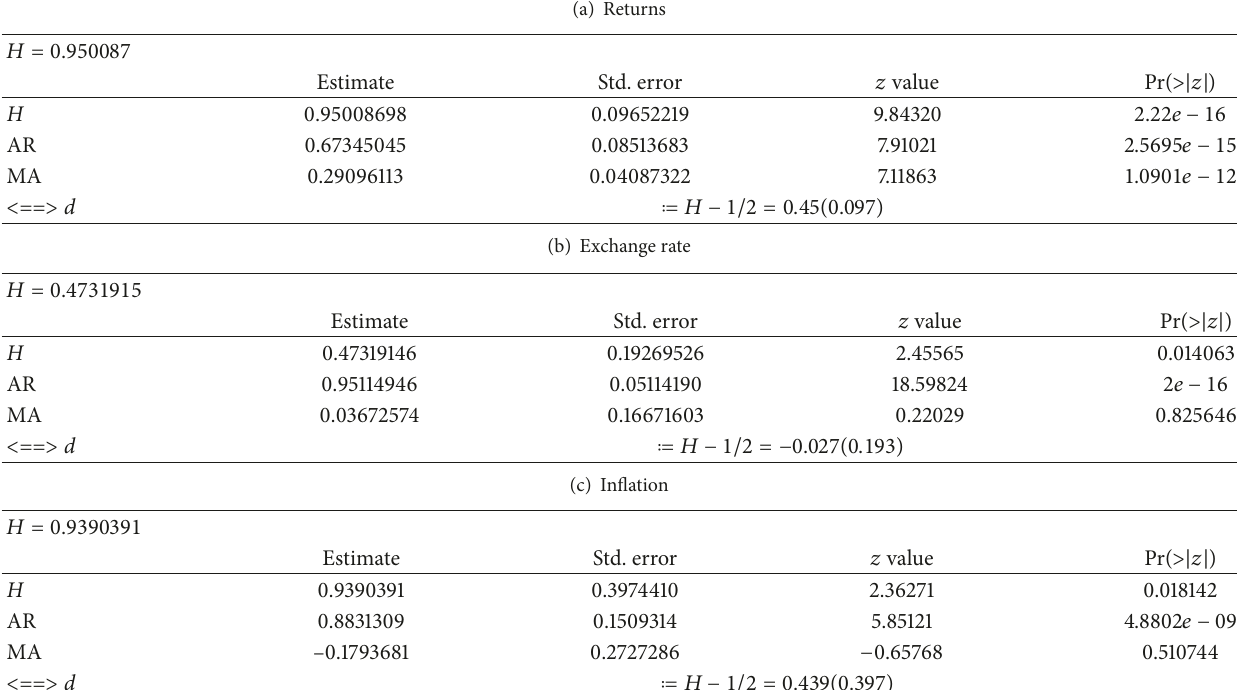
Table 6: R output for ARFIMA